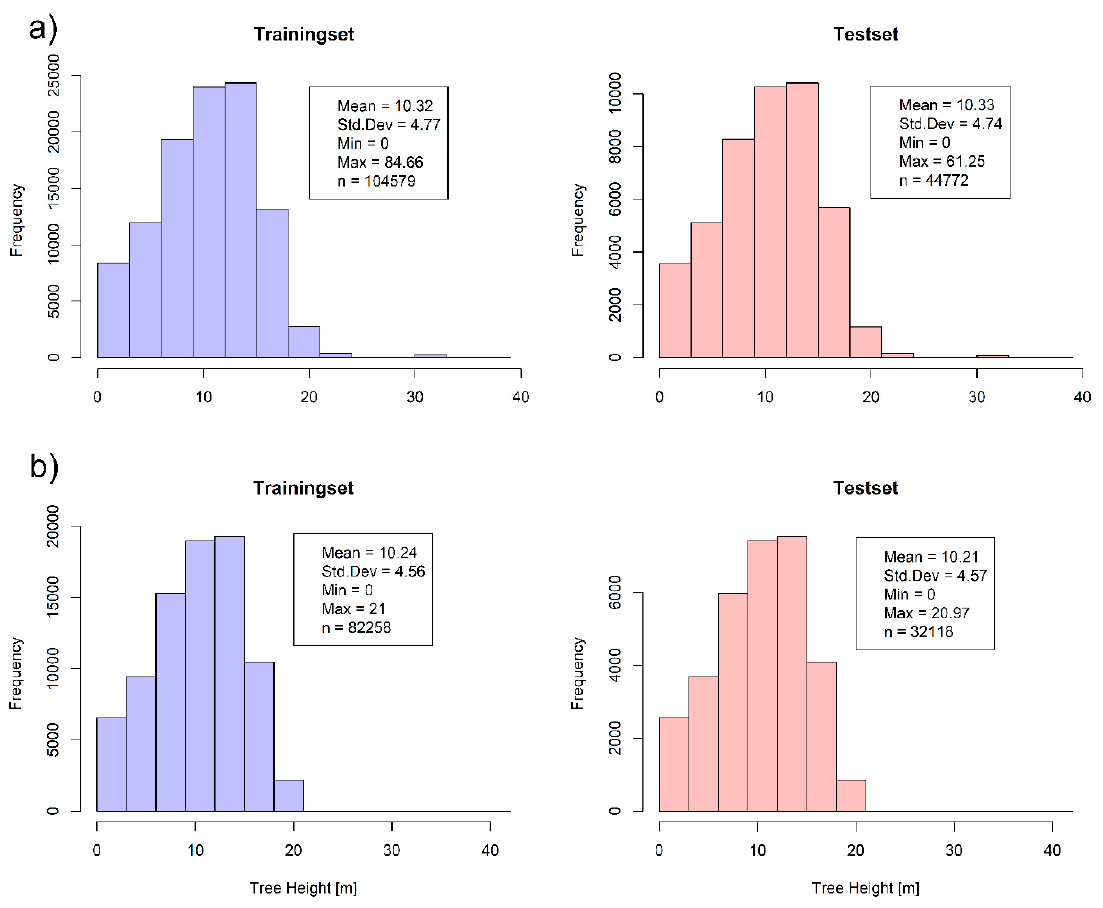
Figure 4. Histograms of LiDAR-based vegetation height data used for training and test using ( a ) “stratified random sampling” (i.e., based on value intervals while ignoring spatial location) and ( b ) “spatial sampling” (i.e., based on spatial location).